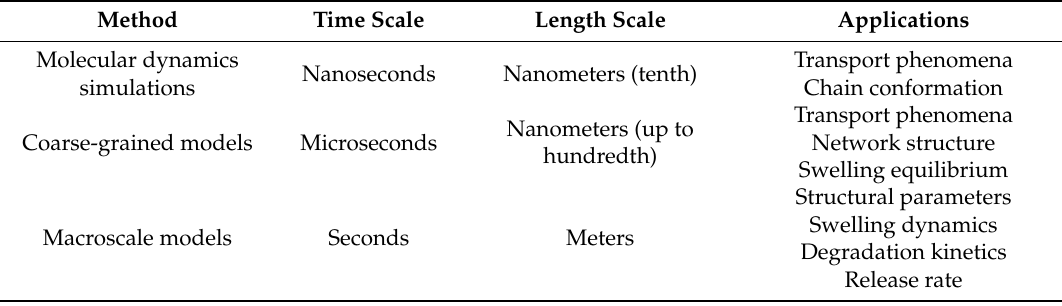
Table 1. Summary of modeling approaches and their main